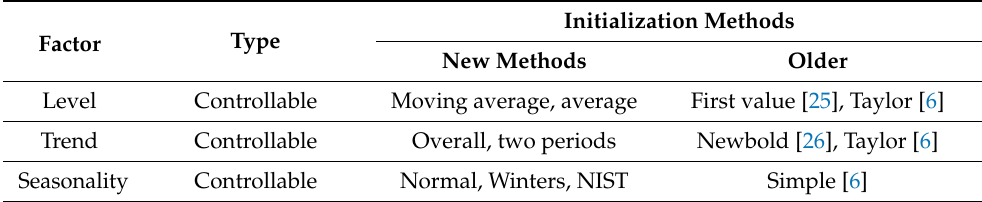
Table 4. The factors and initialization methods analyzed.